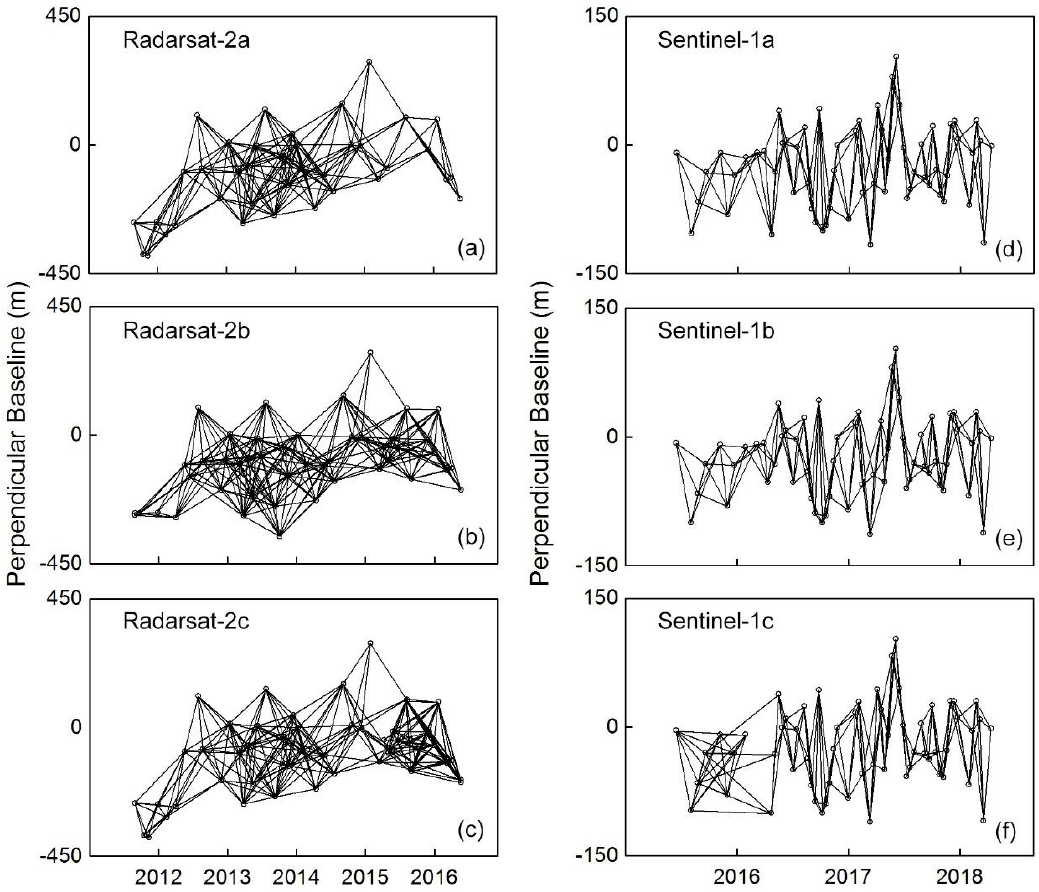
Figure 2. ( a – c ) is the interferograms for Radarsat-2a, Radarsat-2b, Radarsat-2c data and ( d – f ) is the interferograms for Sentinel-1a, Sentinel-1b and Sentinel-1c data, respectively.